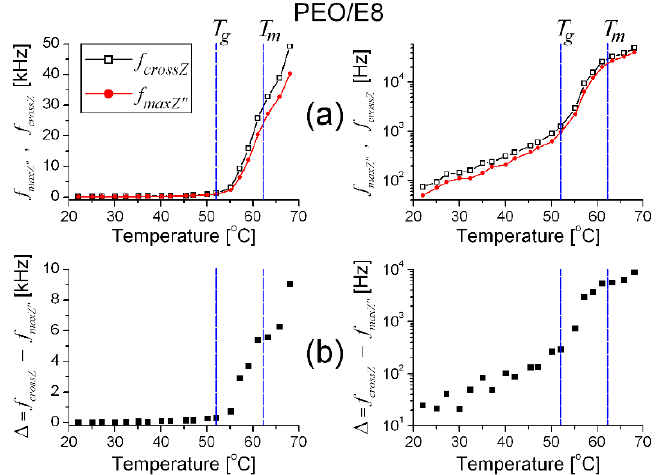
Figure 2. The frequencies f cross and f maxZ ″ ( a ), as well as the difference Δ = f cross − f maxZ ″ ( b ) vs. the temperature for PEO/E8 composite, in linear ( left ) and logarithmic ( right ) scale. The dashed lines point out the glass transition ( T g ) and melting temperature ( T m ) values of the PEO/E8 composite. The uncertainty limits for the experimental data presented are within the size of the symbols for the data.